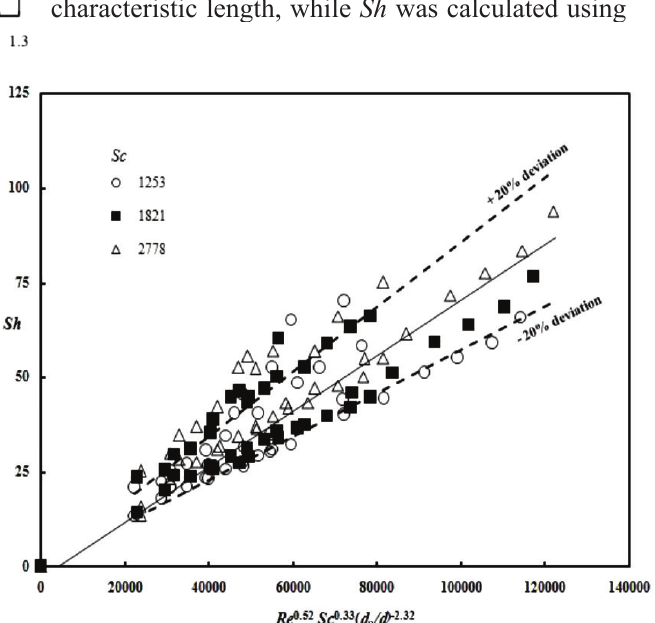
Fig. 7 – Overall mass transfer correlation for a helical coil imbedded in an inert fixed bed of